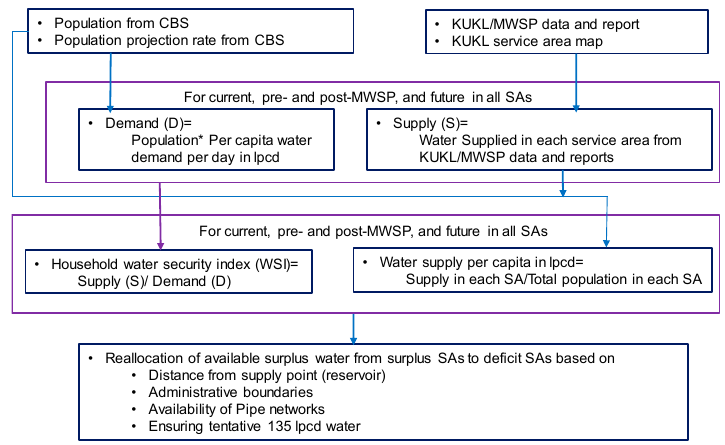
Figure 2. Overall methodological framework (KUKL: Kathmandu Khanepani Upatyaka Limited, MWSP: Melamchi Water Supply Project, SAs: Service Areas, lpcd: liter per capita per day, CBS: Center Bureau of Statistics). Table 2. Data used, source, and extent.